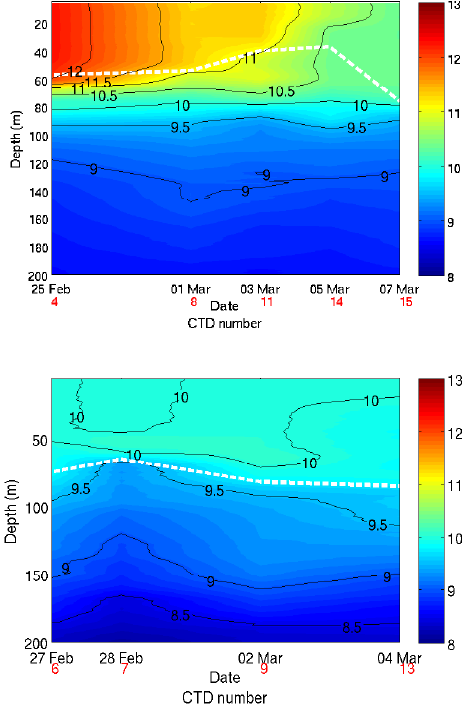
Figure 2. Temperature ( ◦ C) profiles for the summer cruise. (a) Pro- cess station A (b) process station B. The horizontal axis shows the dates in black and the corresponding CTD (conductivity– temperature–depth) numbers in red. The white line represents the MLD (mixed layer depth). The contour lines represent the isotherms. The value of each isotherm is shown in black on the